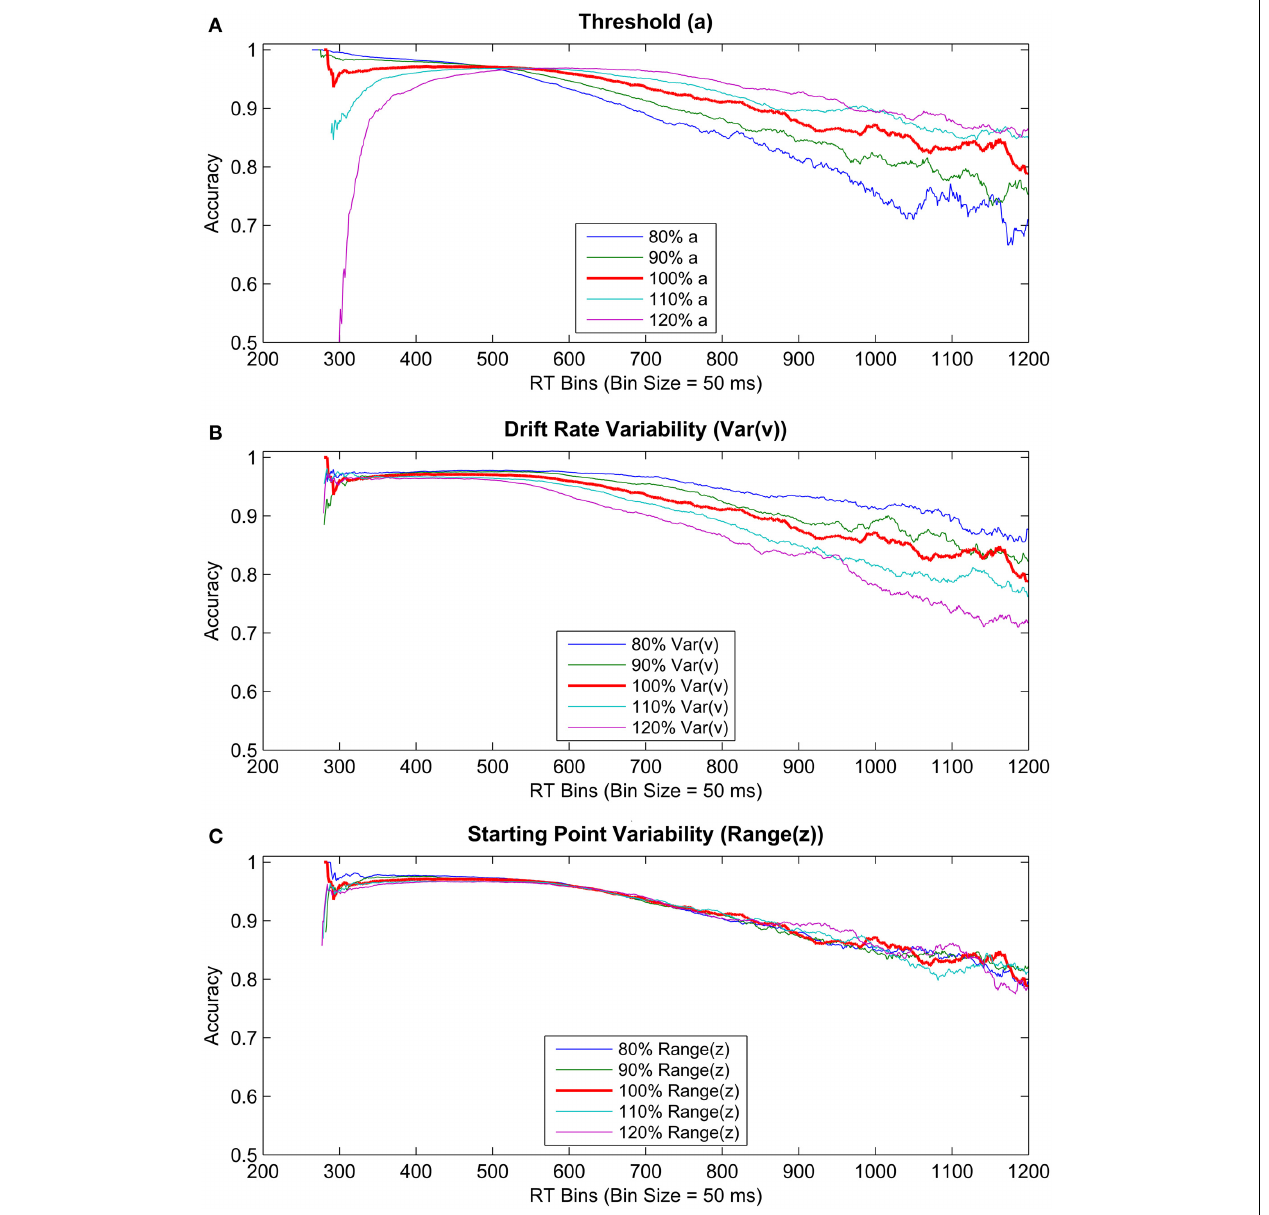
FIGURE 11 | Conditional accuracy curves gathered from simulated data. RT bin size of 50ms was used for plotting. Three parameters were systematically modified by increasing and decreasing their values by 20